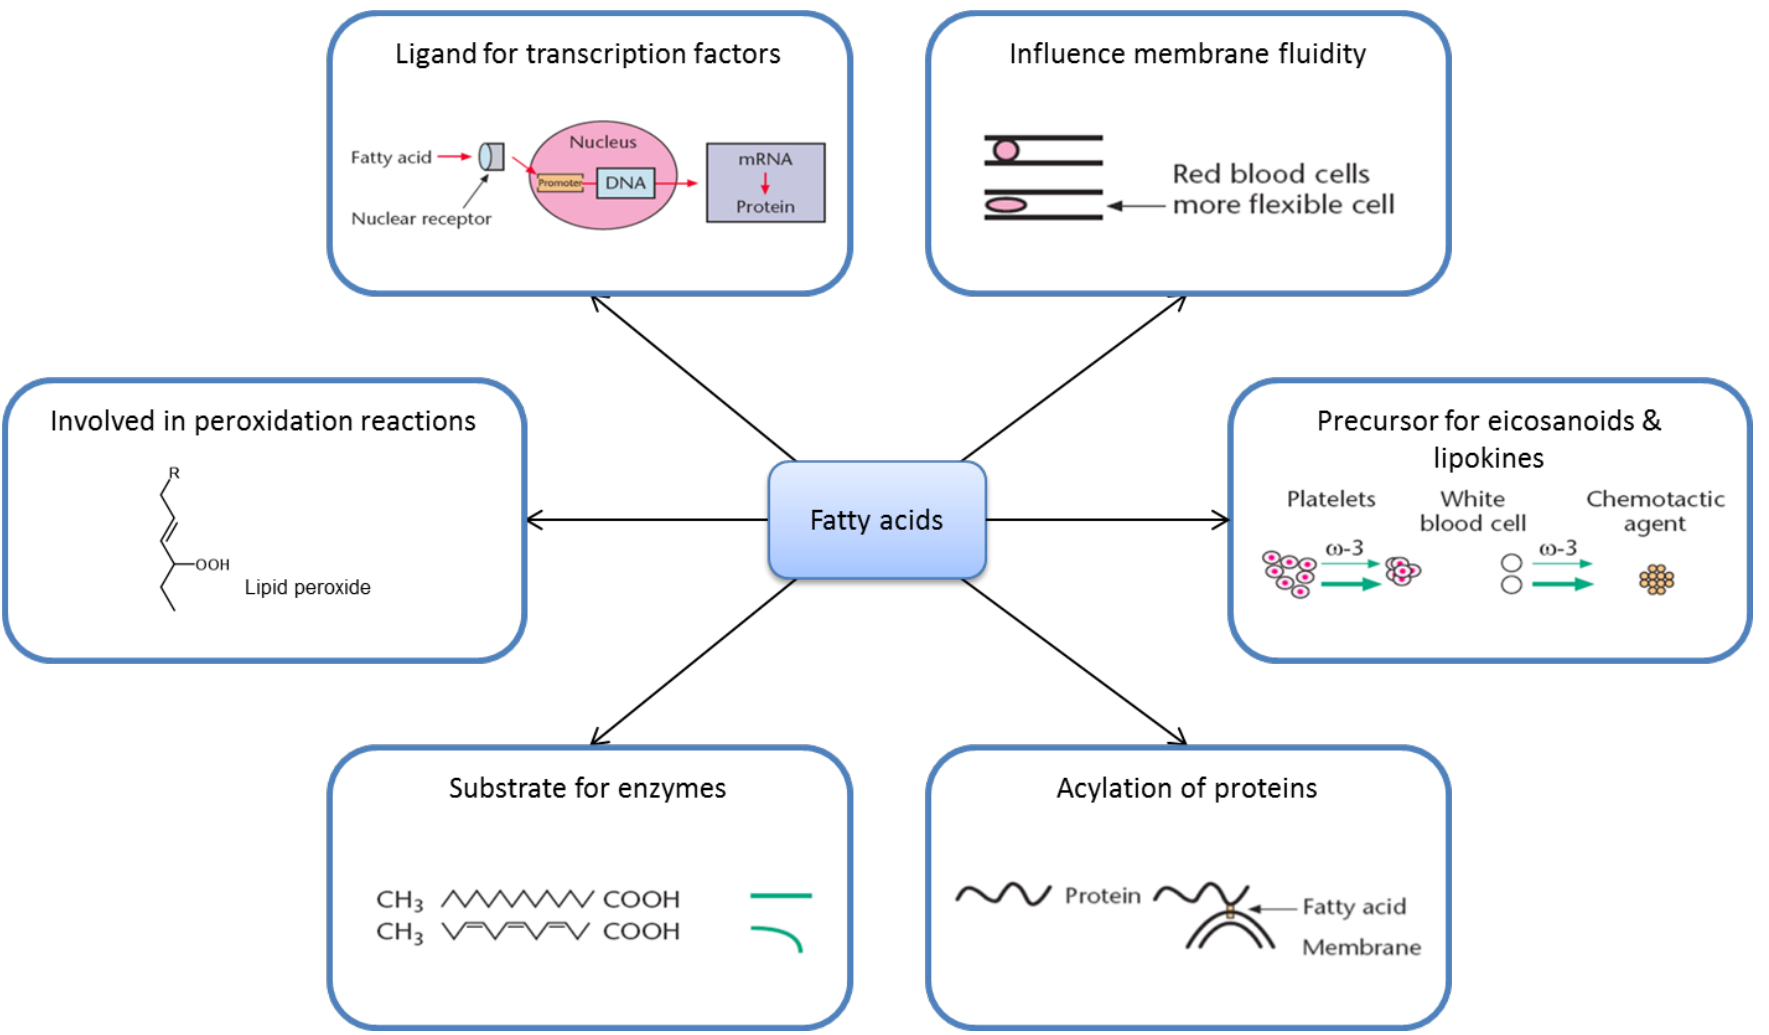
Figure 1. Molecular mechanisms of nutrients exemplified by fatty